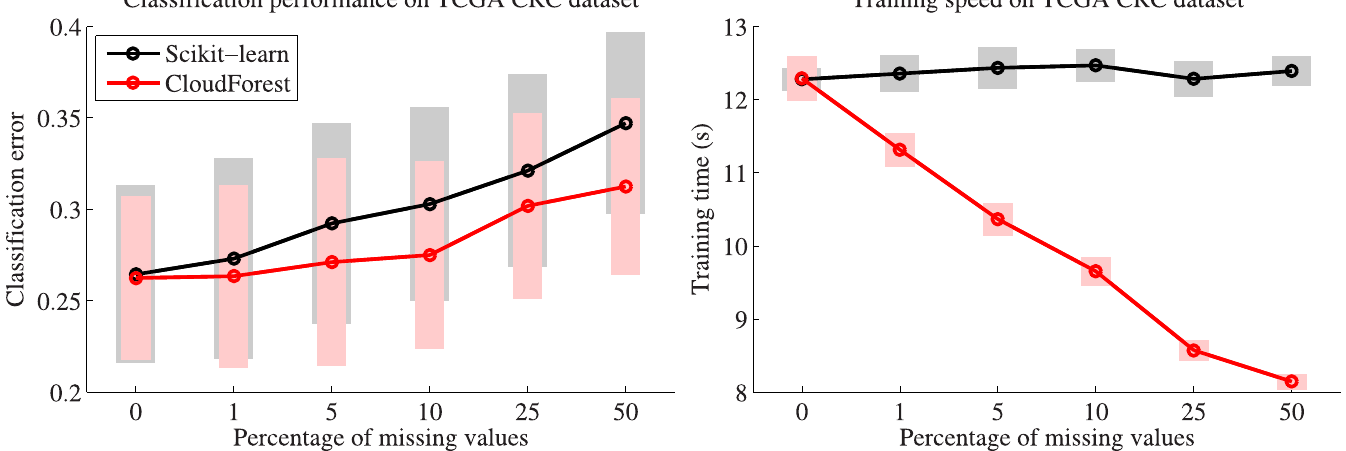
Fig 2. Comparison between CloudForest and scikit-learn in terms of prediction performance ( a ) and training time ( b ) for a TCGA dataset with varying numbers of missing values (x-axis). For scikit-learn missing values are imputed before RF analysis, whereas CloudForest natively handles missing values without imputation. The time necessary for imputation for scikit-learn is not included in the training times